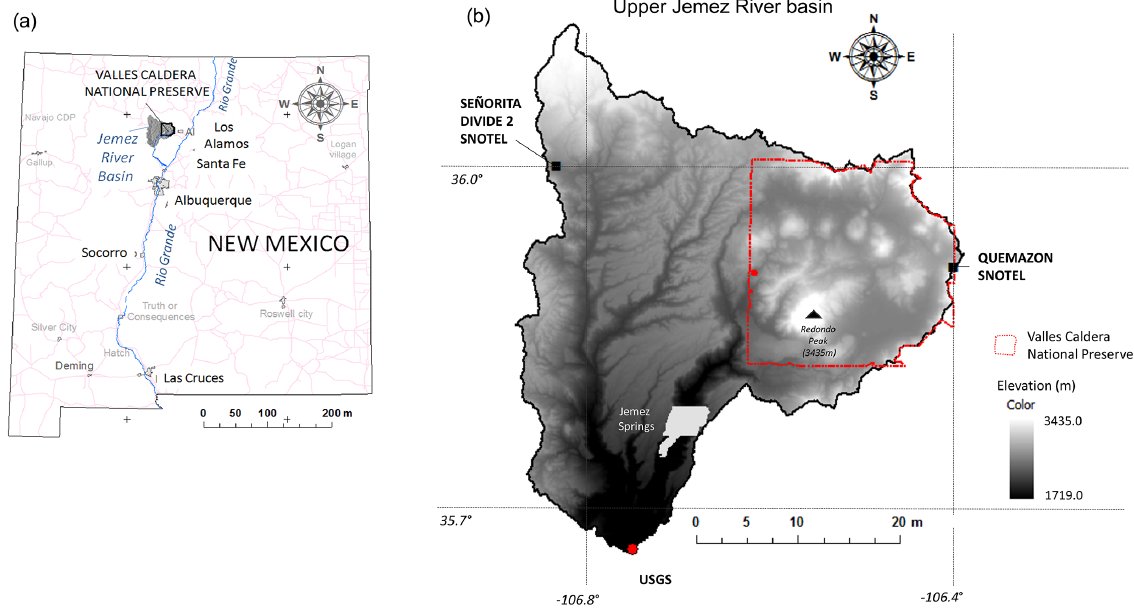
Figure 1. (a) Relative location of study area within the northwestern state of New Mexico, (b) upper JRB, ∼ 1200km 2 , delimited above the USGS gauge station “Jemez River near Jemez” (USGS 08324000) based on a 10m digital elevation model (DEM).